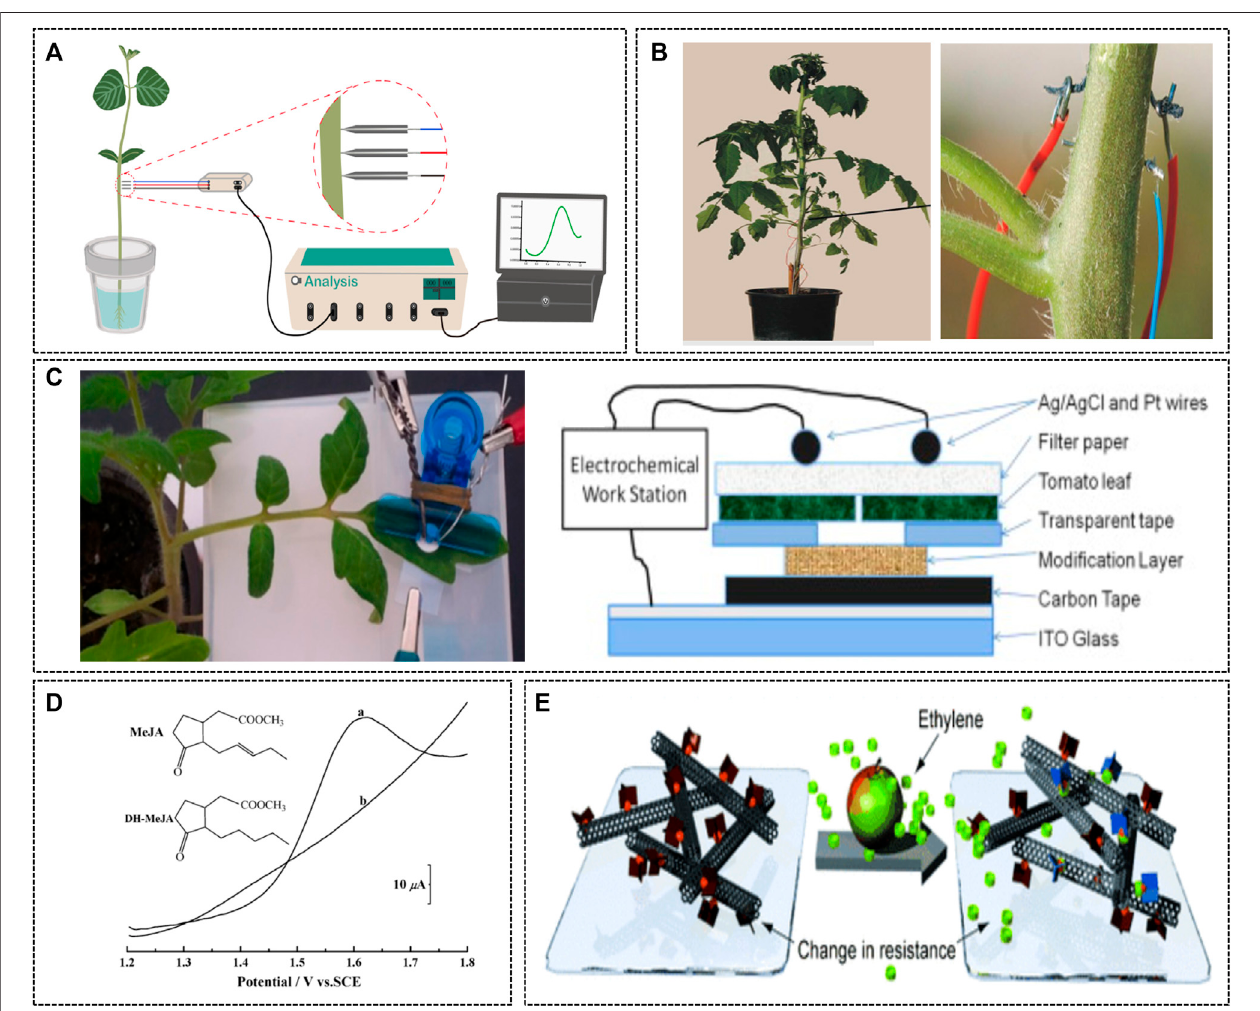
FIGURE 5 | Electrochemical sensor for monitoring plants hormones. (A) A schematic illustration of in vivo determination ofauxins in soybean seedlings (H. Li et al., 2019). Copyright © 2019 (Elsevier). (B) The textile sensor device is implanted in a tomato plant stem for monitoring variations in the solute content of the plant sap (Coppedèet al., 2017). Copyright © 2017 (Nature). (C) Apaper-based electroanalyticaldevice (left) and its cross-section view (right) (Sun et al., 2014).Copyright © 2014 (Elsevier). (D) Square-wave voltammograms of methyl jasmonate (MeJA) and DH-MeJA (Gan et al., 2010). Copyright © 2010 (American Chemical Society). (E) Schematic image of ethylene sensing using a chemoresistive sensor (Esser et al., 2012). Copyright © 2012 (Wiley-VCH).